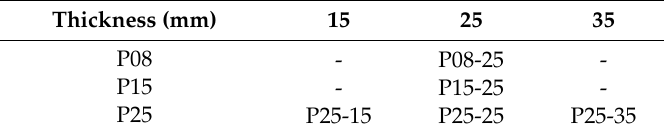
Table 8. The specimen notation scheme with di ff erent